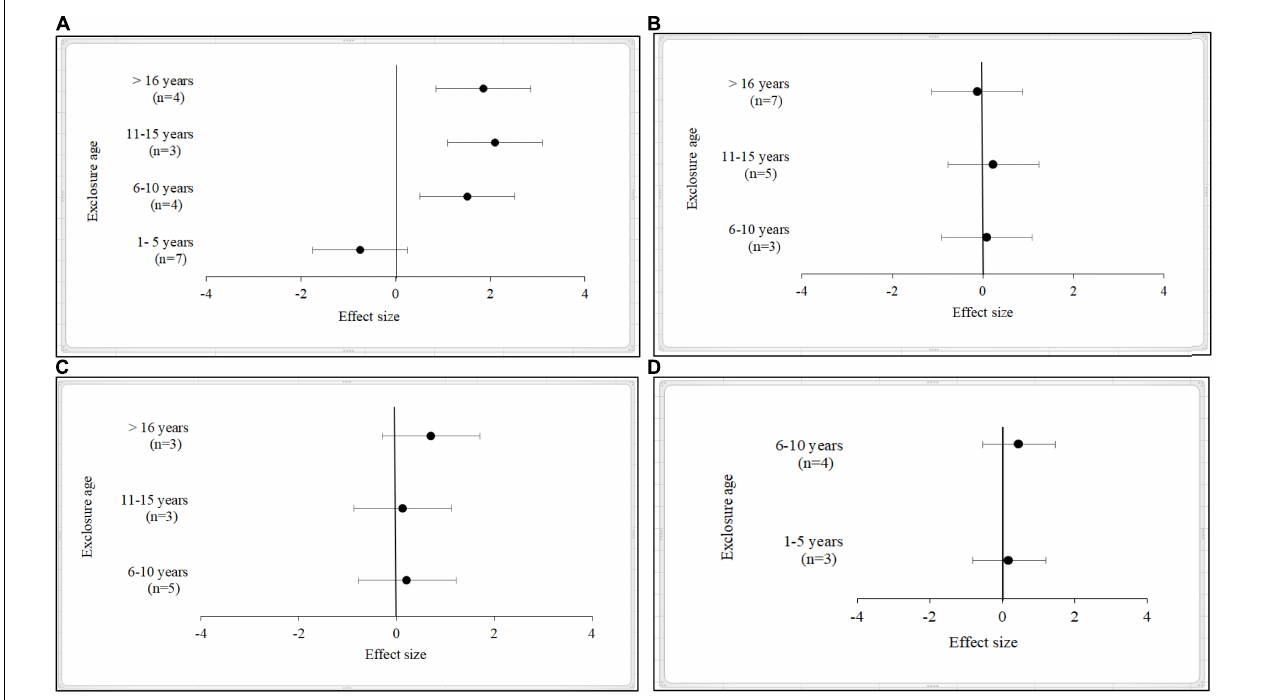
FIGURE 8 | Changes in total soil N after the establishment of exclosures on communal grazing lands in Ethiopia: (A) Dry Dega, (B) Dry Kolla, (C) Dry Weynadega, and (D) Moist Weynadega. See Figure 5 for further details. TABLE 5 | Changes in soil bulk density following the establishment of exclosures on communal grazing lands. Sample size Overall effect size Lower 95% CI Upper 95% CI p